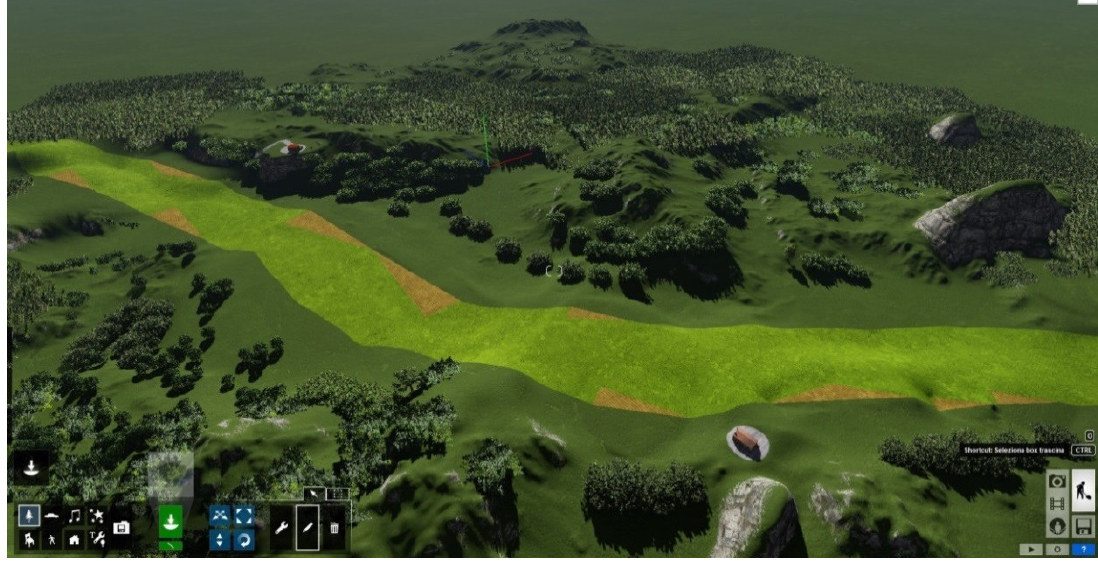
Figure 10. The inclusion of the current flora in the model.